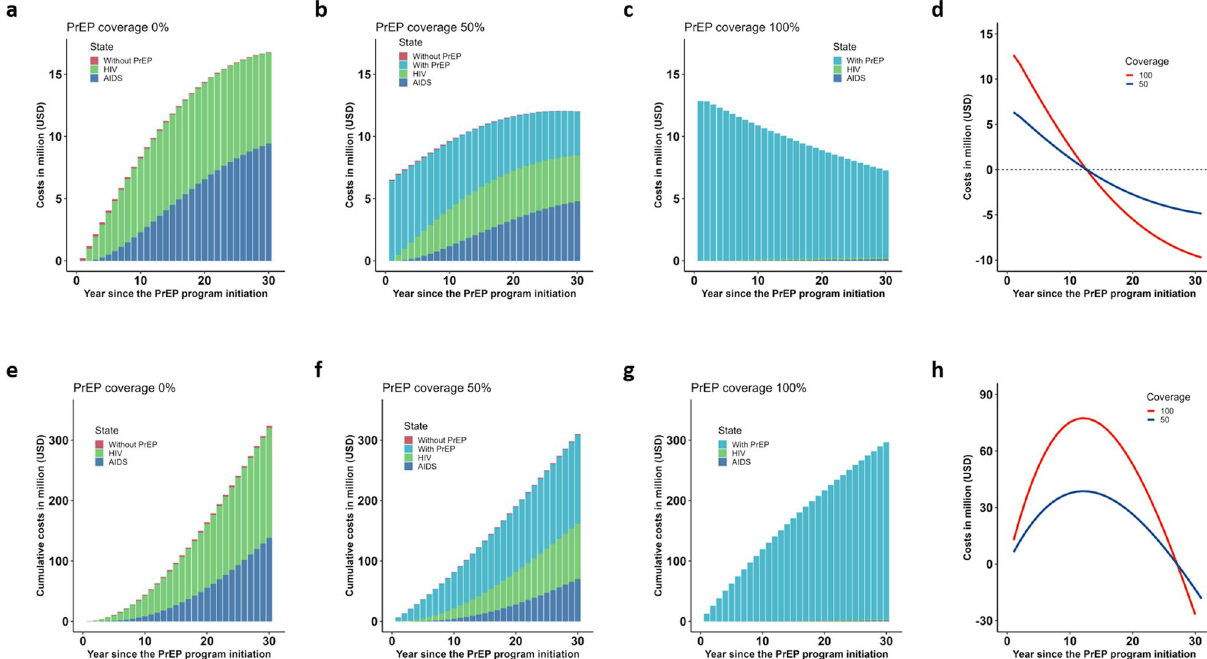
Figure 2. Yearly cost distribution over 30 years. Yearly costs related to treatment, screening, and pre- exposure prophylaxis (PrEP) were computed assuming an annual discount rate of 2%. ( a ) Yearly cost if PrEP is not introduced. ( b ) Yearly cost with the introduction of PrEP to 50% of the cohort. ( c ) Yearly cost with the introduction of PrEP to the whole cohort. ( d ) Difference in yearly cost between when PrEP is introduced with different coverages (50% or 100%) versus when PrEP is not introduced. ( e ) Cumulative cost if PrEP is not introduced. ( f ) Cumulative cost with the introduction of PrEP to 50% of the cohort. ( g ) Cumulative